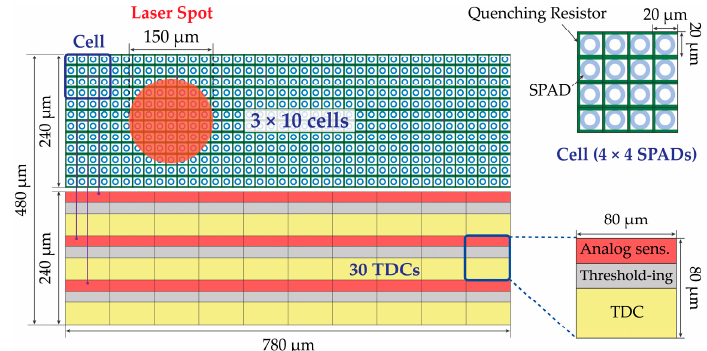
Figure 8. Example of multi-photon SPAD array ( left ), with TDCs shared among a large number (e.g., 4 × 4) of SPADs; an analog sensing block can sum the currents of each SPAD so to trigger the TDC only when a defined threshold is crossed ( right ).